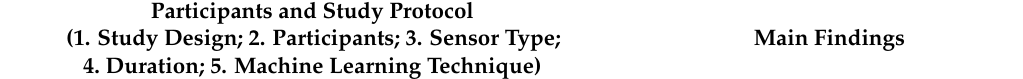
Figure 2. Activity maps of a healthy control ( left ) and a patient with dementia ( right ) visualized from data continuously measured for 20 consecutive days. Activity maps of patients with dementia reveal unorganized behavior patterns, and heterogeneity differed significantly between the healthy control and the patient. The figure is adapted from Urwyler et al. [30] (CC BY 4.0).